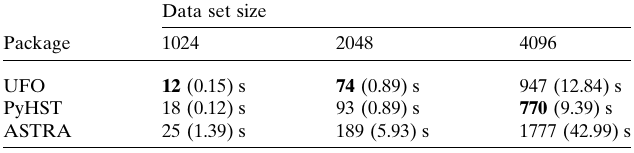
Table 3 Reconstruction times of different software packages for different data set sizes.